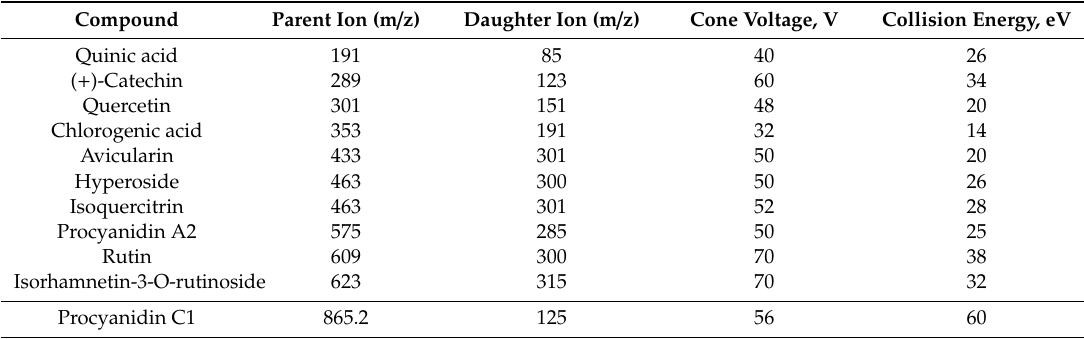
Table 3. Mass spectrometry parameters for the analysis of phenolic compounds and quinic